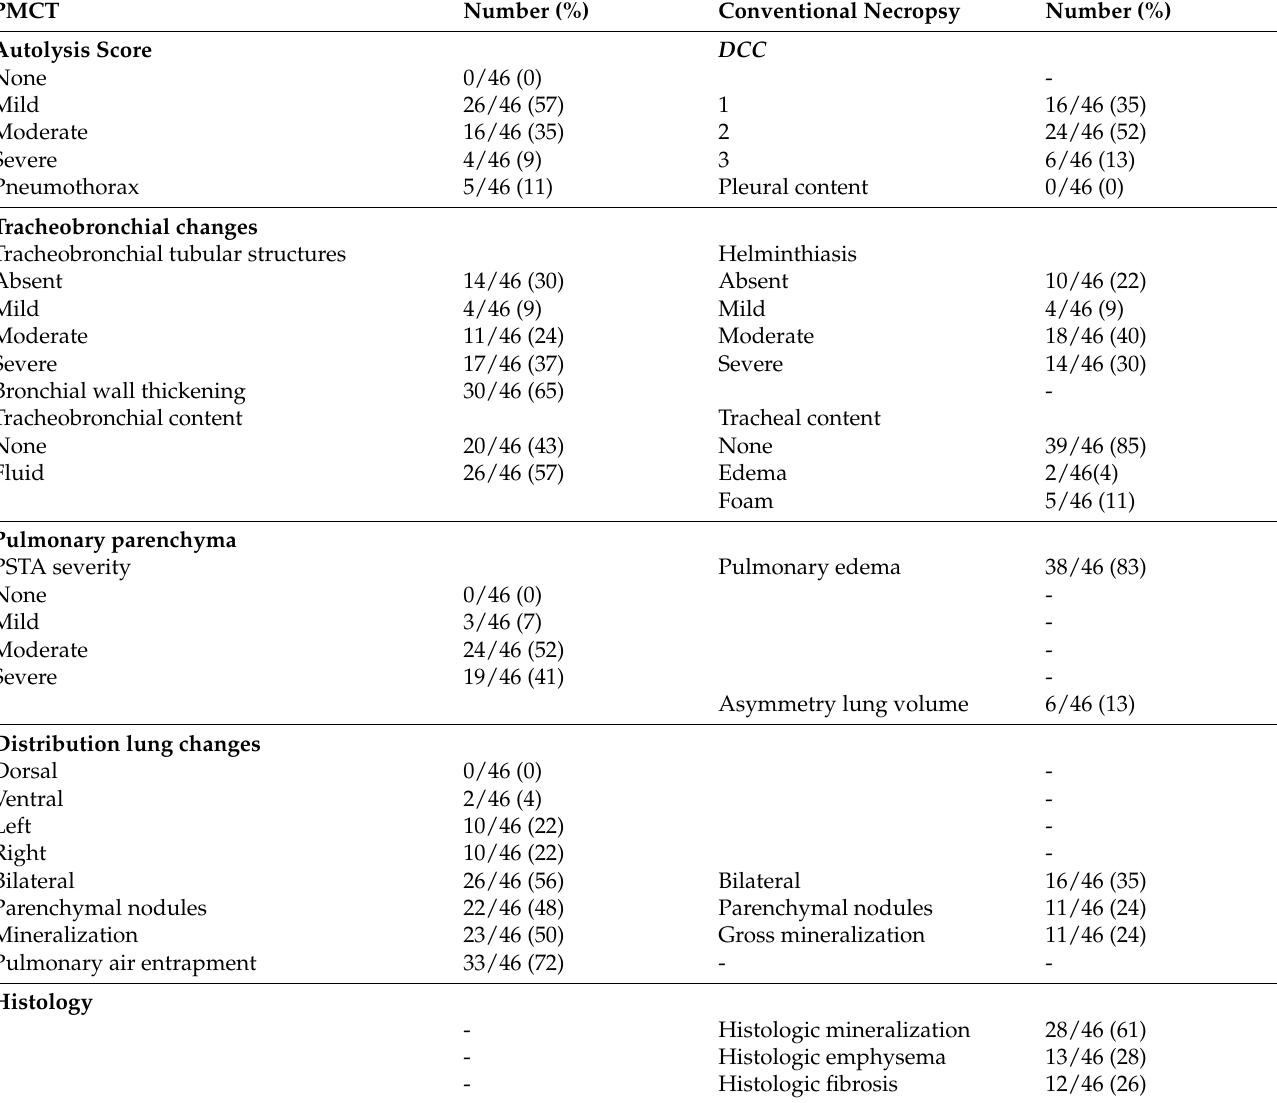
Table 3. PMCT and conventional necropsy evaluation score